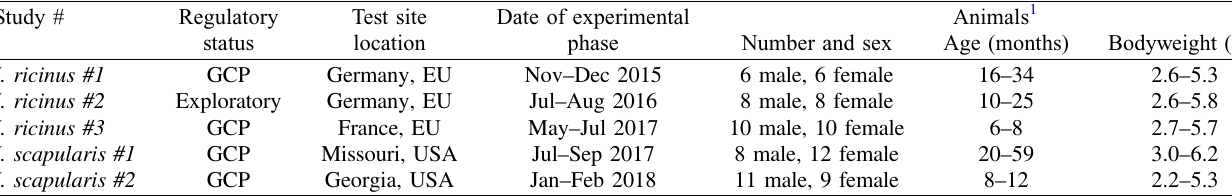
Table 1. Regulatory context, location, timing and animals by